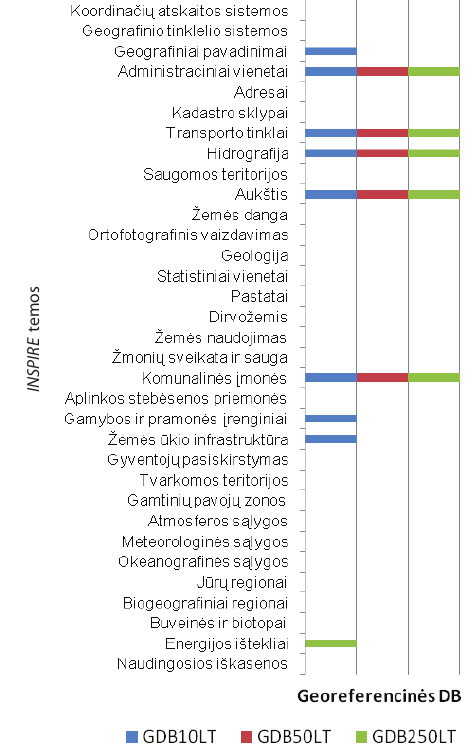
Fig. 6. Correspondence of Lithuanian georeference